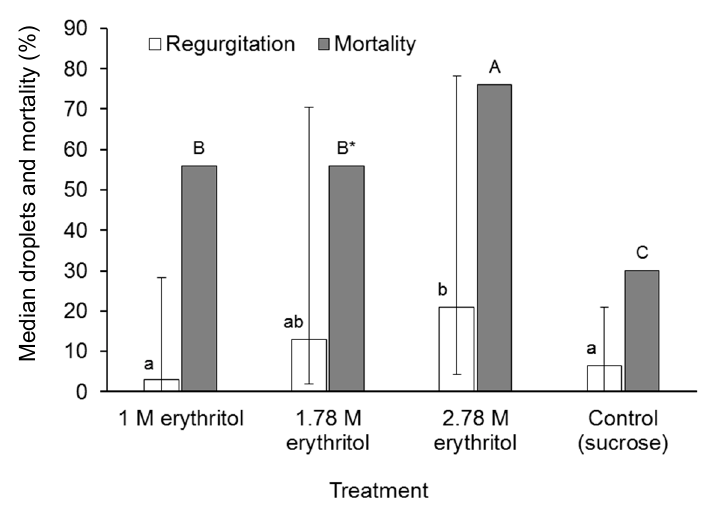
Figure 6. Median regurgitated droplets (open columns) deposited on cup walls by A. ludens flies individually exposed to three different concentrations of erythritol in 50% sucrose or 50% sucrose alone (control), and percentage of mortality (shaded columns) of flies in the three-day post-treatment period. Vertical bars indicate interquartile range. Identical letters above columns indicate no significant differences in regurgitation (lower case, Dwass–Steel–Critchlow–Fligner (DSCF) multiple comparison test p > 0.05) or mortality (upper case, log-rank test, p > 0.05). * Comparison of 1.78 M erythritol treatment and control was borderline significant (log-rank test, p = 0.055).